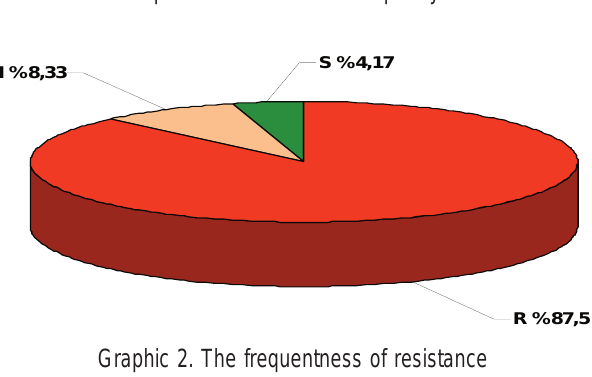
Graphic 1. Resistance to streptomycin